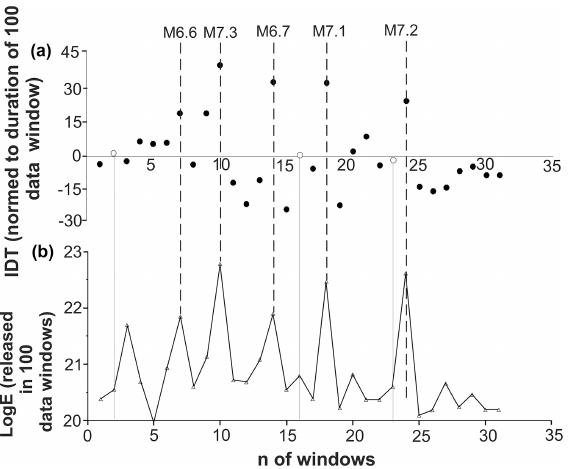
Figure 13. Calculated for the non-overlapping 100 data windows (shifted by 100 data), integral deviation times (IDTs) (circles in panel a ) and the released seismic energies (triangle in panel b ). IDT values in vicinity of 0 . 1 σ from zero are given by open circles in panel (a) . By grey lines we show location of closest to zero IDT values relative to the released seismic energy. Dashed lines show the occurrence of largest earthquakes in the southern California cat- alog (above threshold M = 3 .